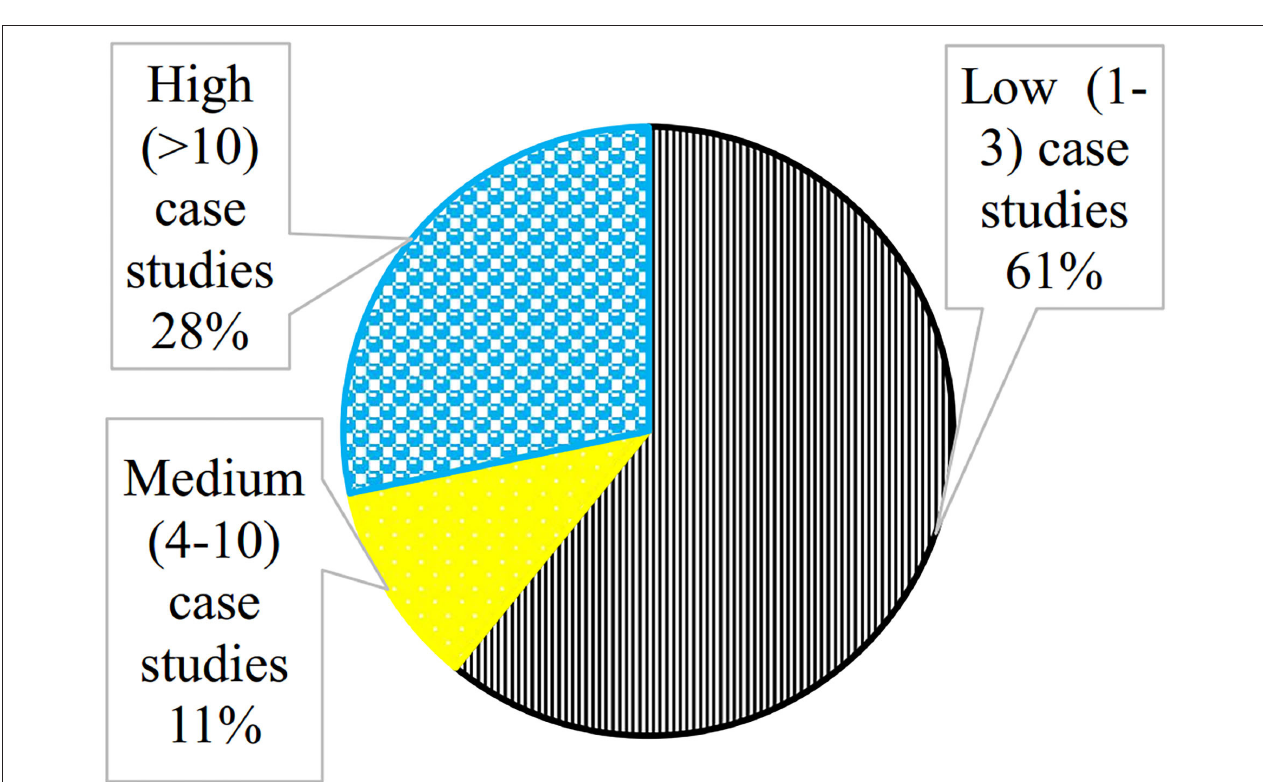
FIGURE 11 | WEF tools in case